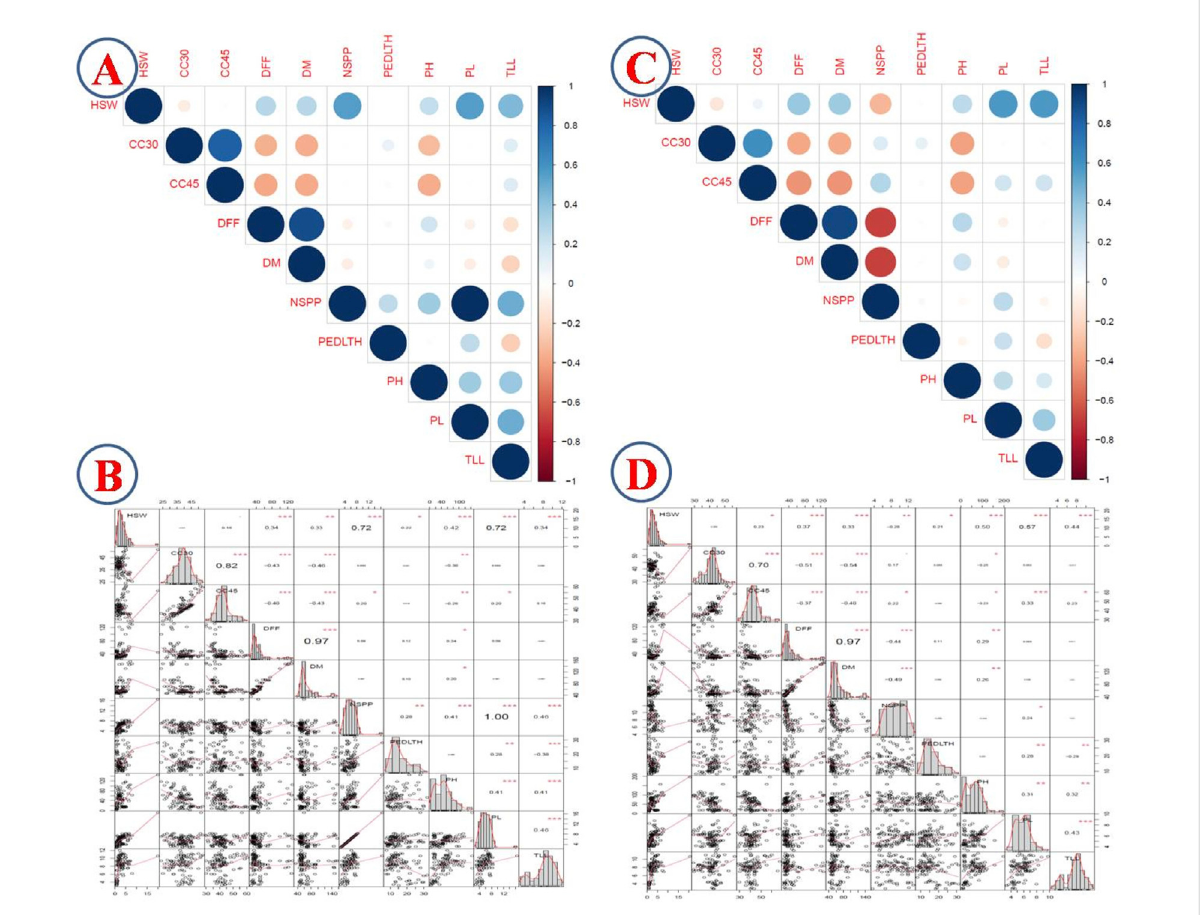
FIGURE 1 Correlation analysis of quantitative traits with BLUP values; (A) correlogram of 2017 data; (B) correlation table of 2017 data; (C) correlogram of 2018 data; (D) correlation table of